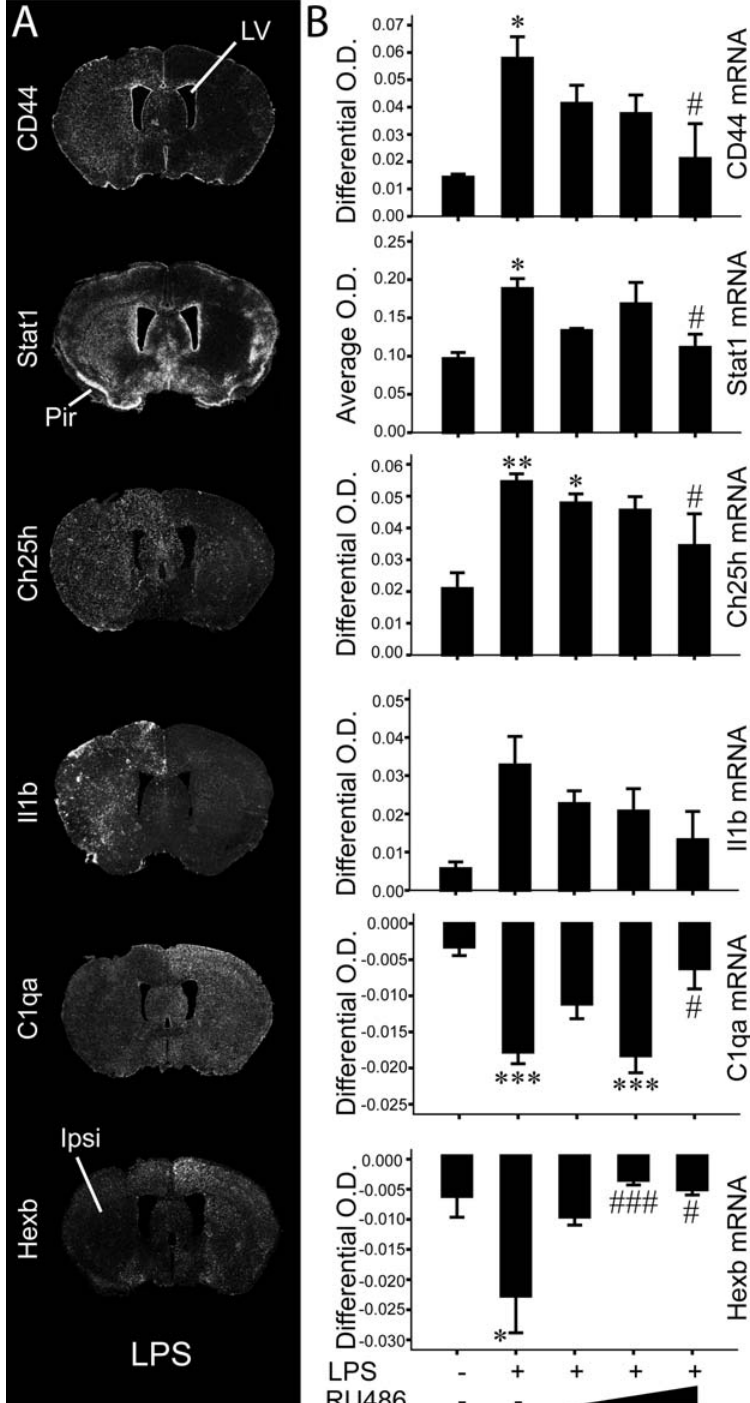
Figure 4. Validation of genes upregulated or downregulated by LPS in a glucocorticoid-dependent manner. (A) Representative examples of coronal sections depicting LPS induced changes in gene expression of the indicated transcripts. (B) Semi-quantitative analysis of mRNA levels (O.D.) in mouse brains 12 h after the intracerebral infusions. One-way ANOVA followed by a Tukey’s HSD multiple comparison test: significantly different (* p , 0.05, ** p , 0.01, *** p , 0.005) from the saline-injected group; significantly different ( # p , 0.05, ### p , 0.005) from the LPS-treated group. Abbreviations: Ipsi, ipsilateral; LV, lateral ventricle; Pir, piriform cortex.